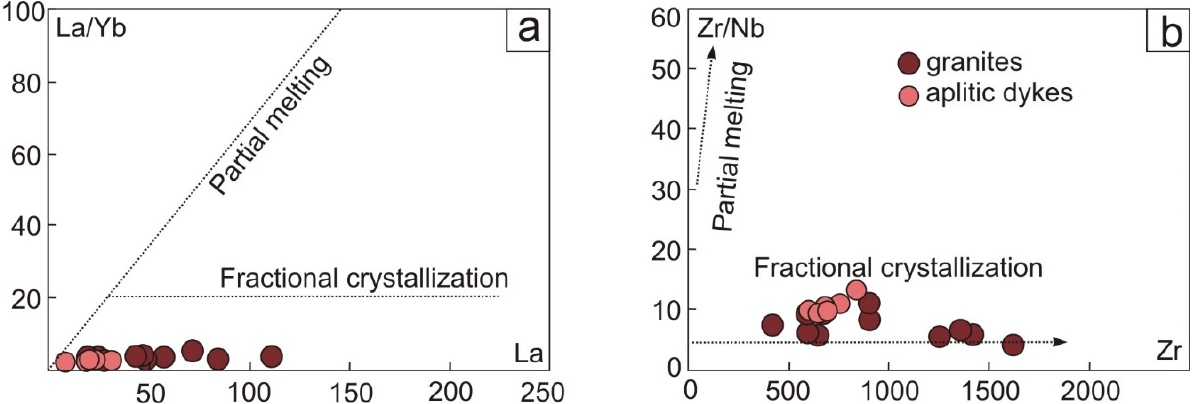
Figure 9. Binary diagrams showing the dominant role of the fractional crystallization process during the evolution of magma for peralkaline granitic rocks from the Tannuola terrane: ( a ) La/Yb–La; ( b ) Zr/Nb–Zr.